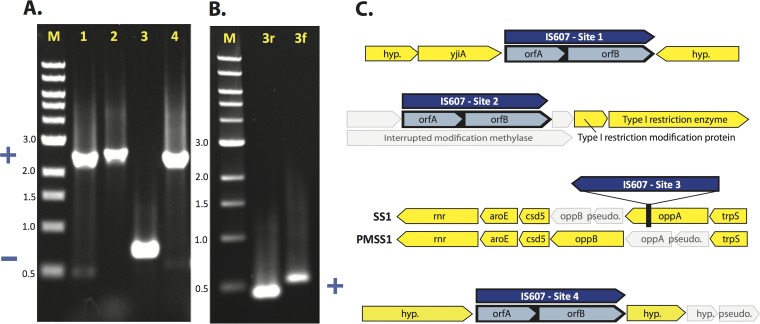
IS607 is variably present at four sites in the SS1/PMSS1 genomes. (A) PCR performed on the sequenced SS1 genomic DNA sample, using primers flanking the four SS1 IS607 insertion sites (lanes 1 to 4), showing larger bands where the site contains IS607 (+) and smaller bands where the site does not contain IS607 (-). M, 1-kb DNA marker. (B) PCR performed on the same genomic DNA sample, using primers located within IS607 paired to the flanking (3f and 3r) primers for site 3, demonstrating that IS607 is present at site 3 within the sequenced population, despite the predominance of the IS607(-) product seen using the flanking primers alone. (C) The genomic context of the four IS607 insertion sites in SS1/PMSS1. IS607 is shown in blue; disrupted and presumably nonfunctional genes are shown in gray. Sites 1 and 4 are not always occupied in SS1, but site 2, which disrupts an R/M system, is invariably occupied. The genomic contexts of the insertion sites are identical for SS1 and PMSS1 except for SS1 insertion site 3. At site 3, IS607 is inserted into the otherwise intact oppA gene in a small subpopulation of SS1; no such insertions were observed in PMSS1, although the oppA gene is already disrupted in PMSS1. hyp., hypothetical gene; pseudo., pseudogene.